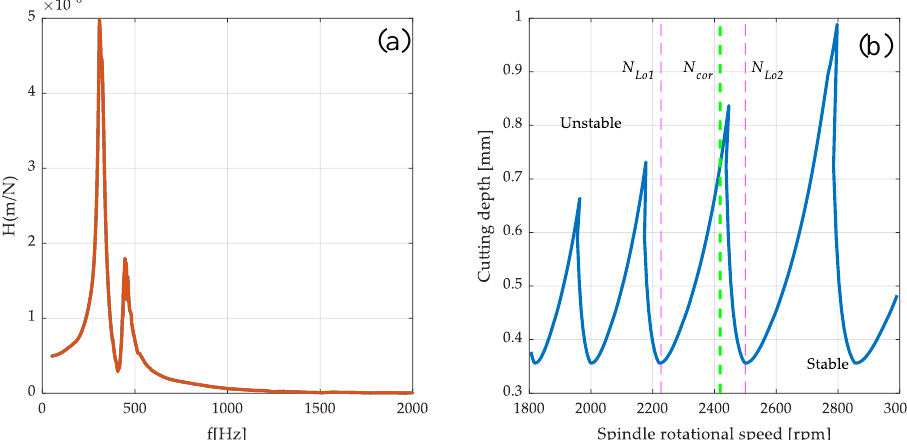
Figure 14. Stability analysis: ( a ) FRF at the end of the workpiece based on RCA ( b ) Stability lobes.